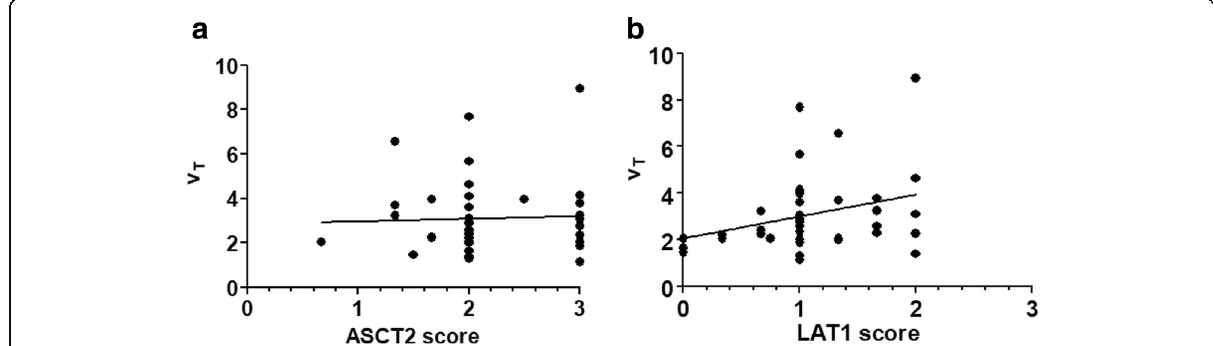
Fig. 3 Correlation between 18 F-fluciclovine distribution volume ( V T ) and amino acid transporter expression. On the x -axis, the average staining intensities of ASCT2 and LAT1 in each separate tumor lesion are depicted. Linear regression is shown to demostrate correlation between V T and ASCT2/LAT1